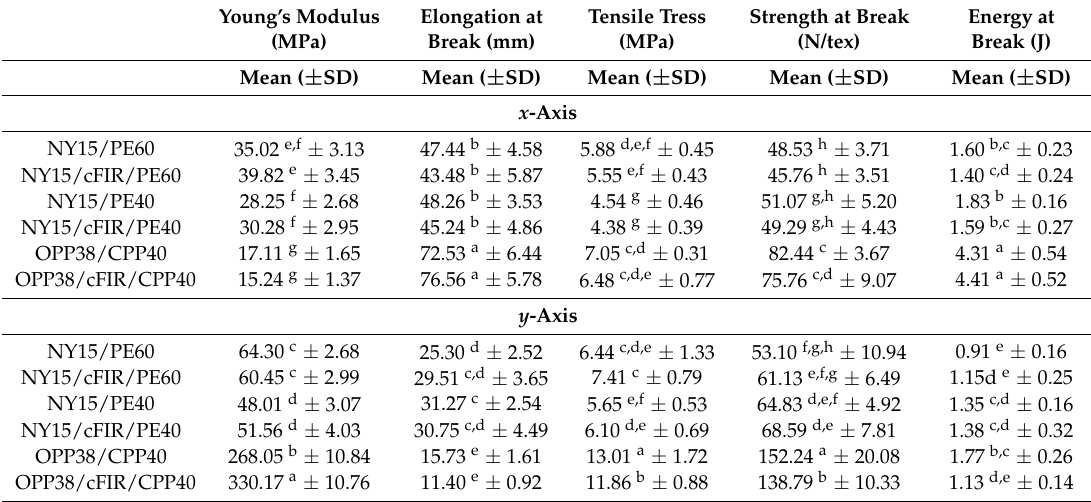
Table 1. Mechanical properties of far-infrared composite materials along the x -axis and the y